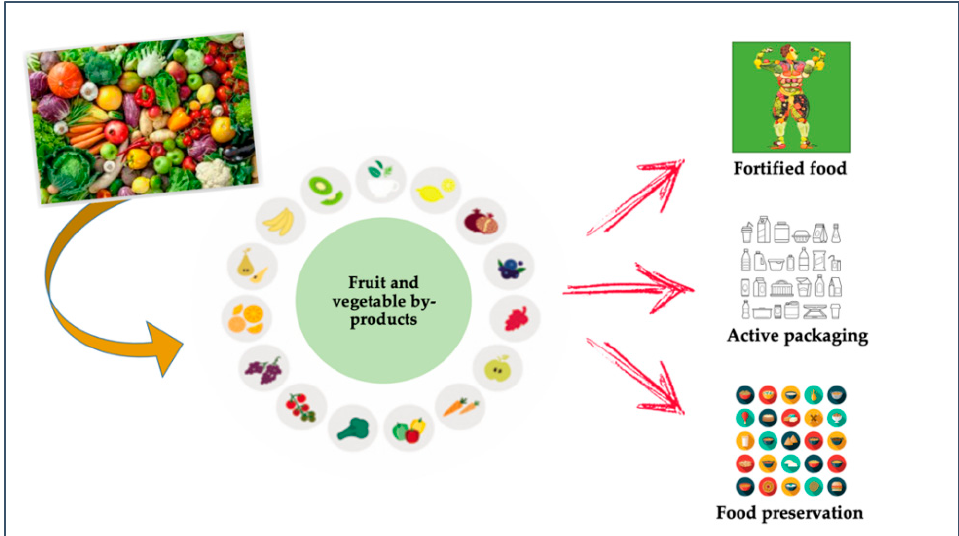
Figure 1. New directions in managing fruit and vegetable by-products.